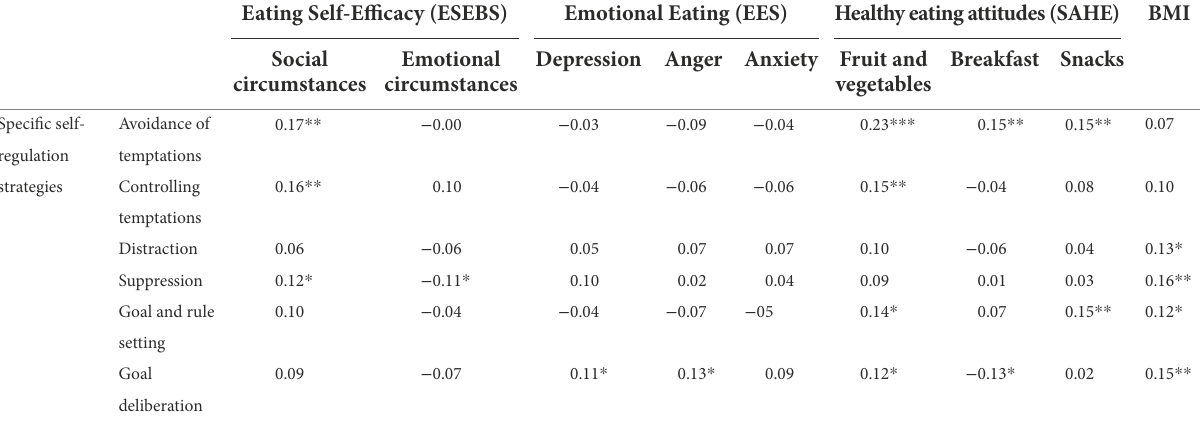
TABLE 4 Correlations between the six TESQ-E subscales and the other self-regulated eating